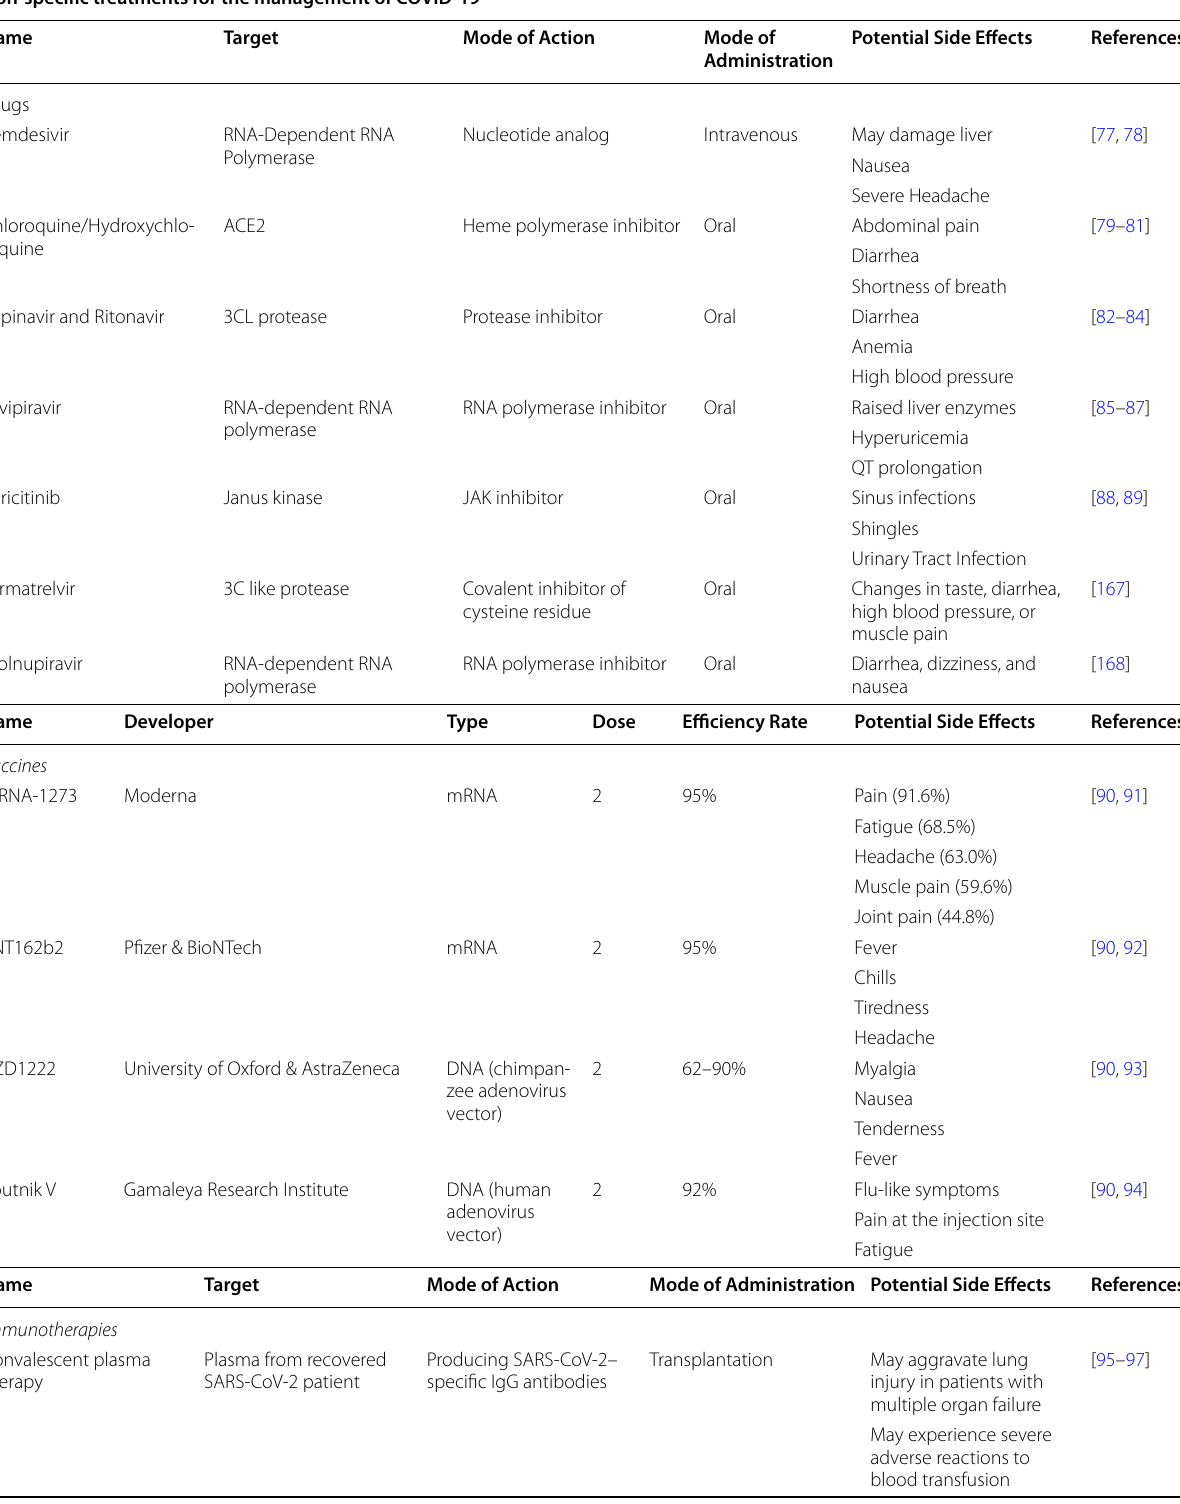
Table 4 Possible non-specific treatments for the management of COVID-19 Non-specific treatments for the management of